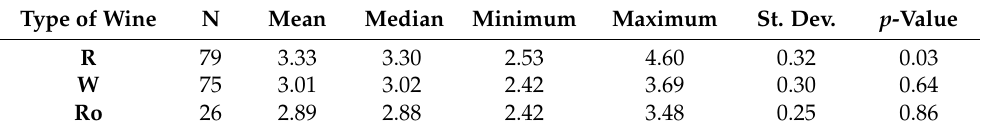
Table 6. Basic statistical parameters of the pH results of all tested wines with a distinction between wine